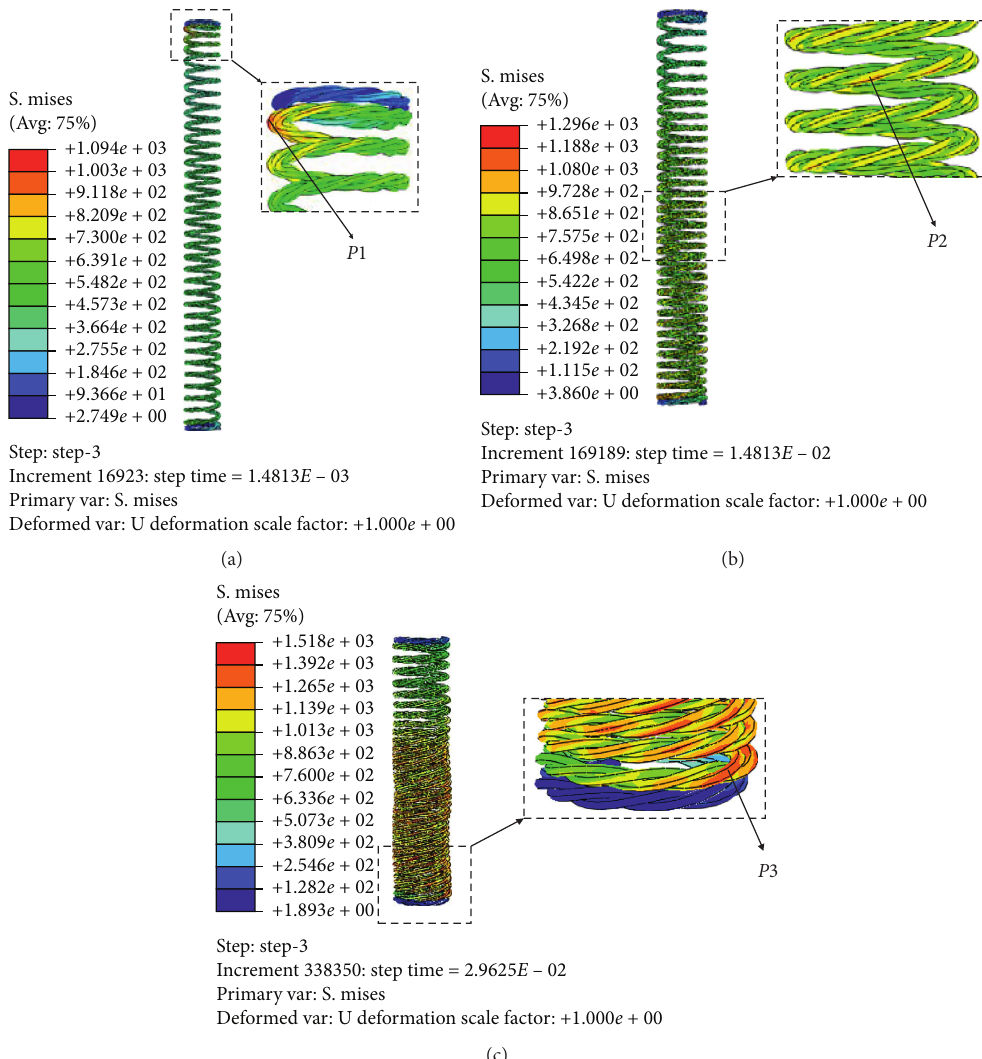
Figure 10: Stress contours of recoil spring at different moments during recoil. (a) t � 0.0015s. (b) t � 0.015 s. (c) t �